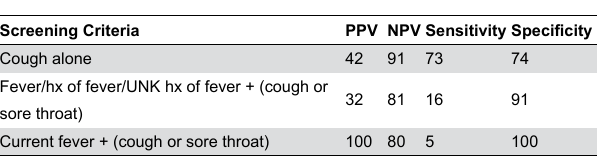
Table 1. A comparison of screening criteria based on results of the 19 May, 2009 active screening, Camp